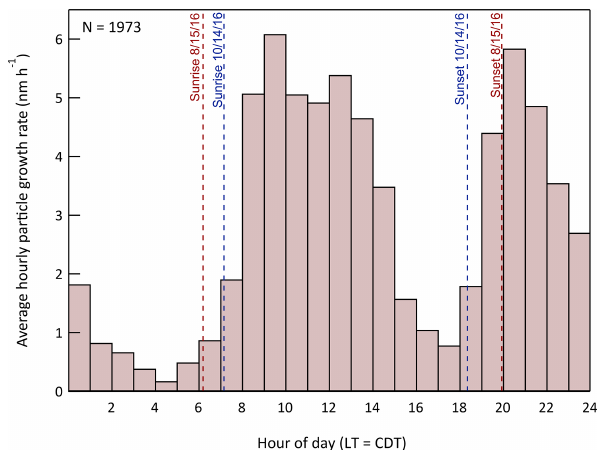
Figure 16. Hourly average particle growth rate during the study. A total of 1973 values were used to construct the histogram. The times of sunrise and sunset for the first (15 August) and last (14 October) day of measurements are also